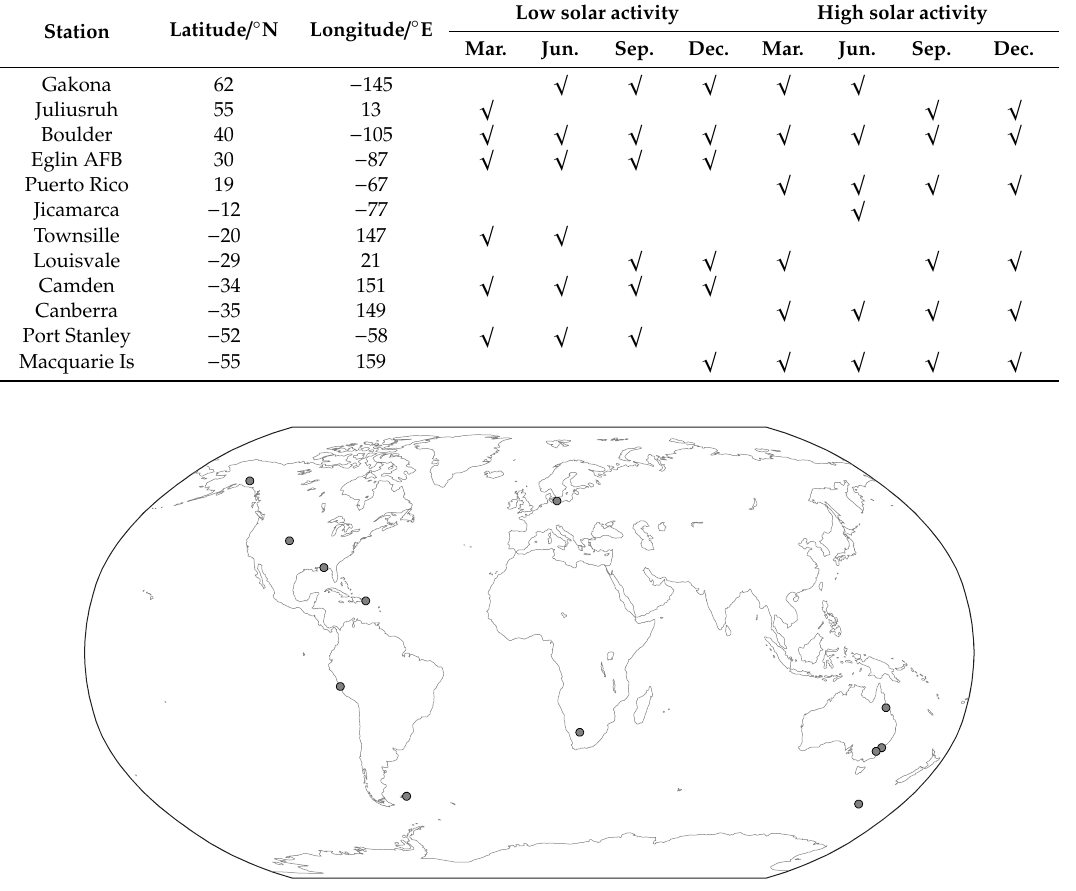
Figure 6. Global map of used ionosonde stations .